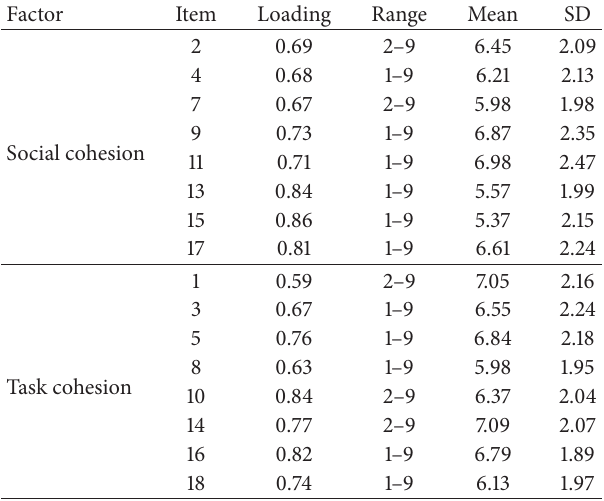
Table 1: Descriptive statistics and standardized factor loadings for confirmatory factor analysis ( 𝑁 = 455